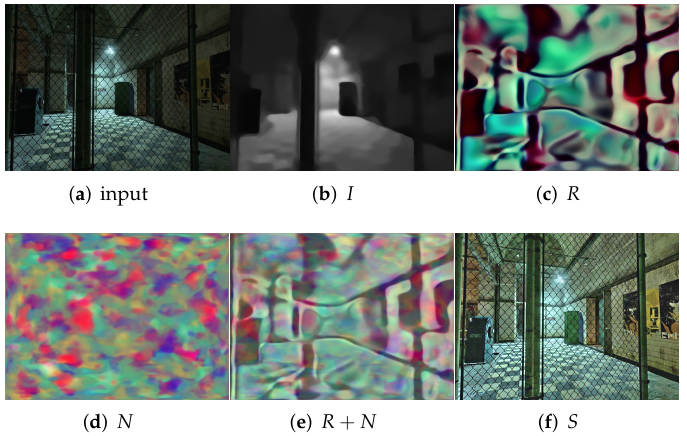
Figure 2. Results of each step of our method: ( a , f ) are the input image and enhanced result; ( b – e ) represent illumination I , reflectance R , noise N , and R + N